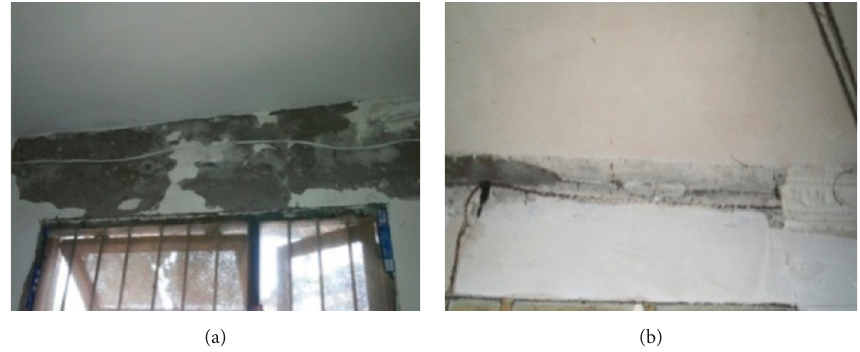
Figure 5: Cracks of floor and wall contact